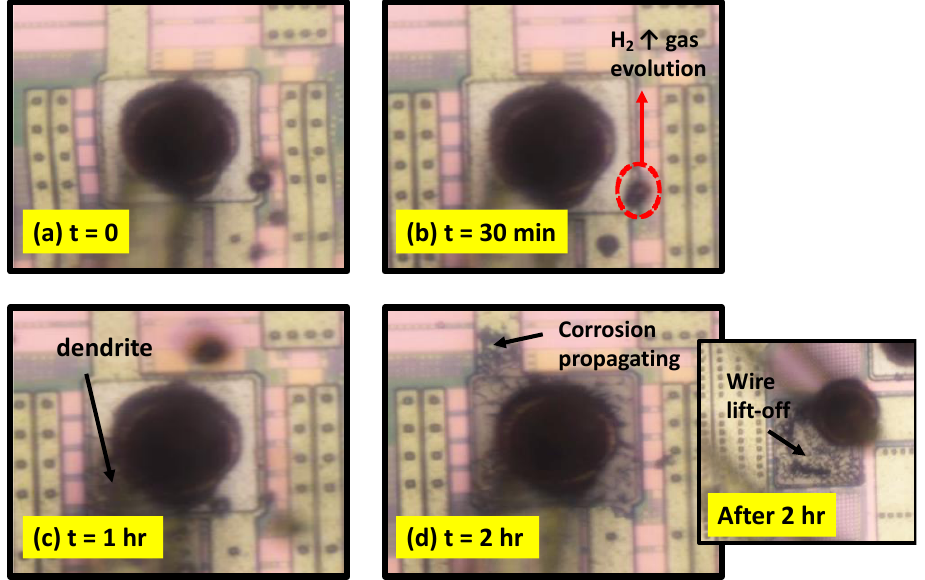
Figure 10. Real-time corrosion progression of WBD (Cu wire on Al bond pad) in 5 ppm Cl − , pH 5 solution ( a ) immediately after immersion, ( b ) H 2 evolution from Cu/Al interface, ( c ) dendrite initiation and propagation, and ( d ) complete corrosion of Al pad, resulting in Cu wire lift-off (wire lift-off microscope image, inset).